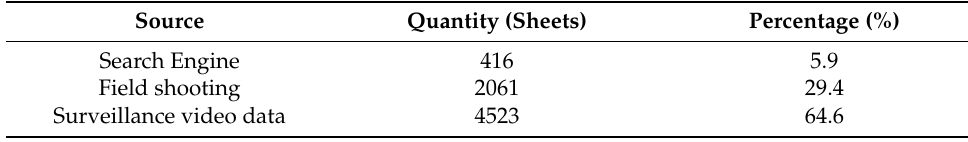
Table 2. Statistics of the number of data sources.